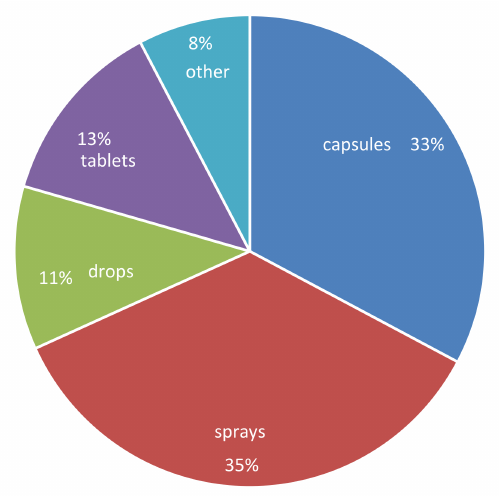
Figure 1. Frequency of usage of different formulations of vitamin-D-containing food supplements (Slovenia, 2020; N =